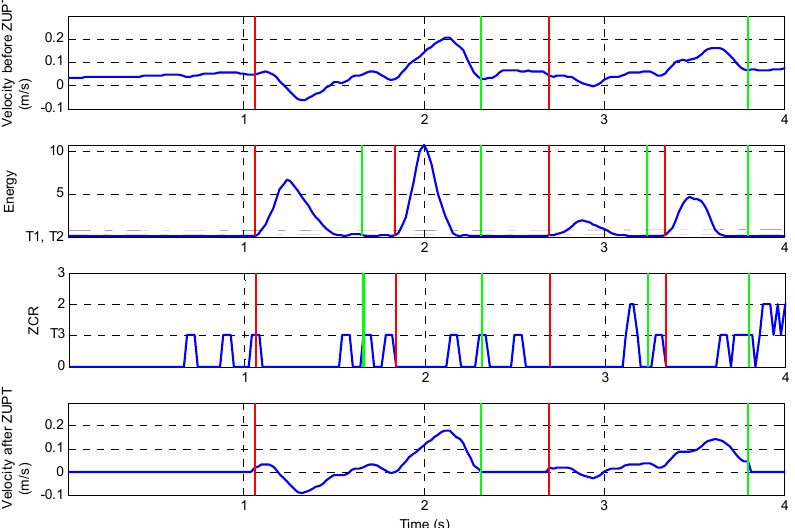
Figure 7. Flow-chart of double threshold method.